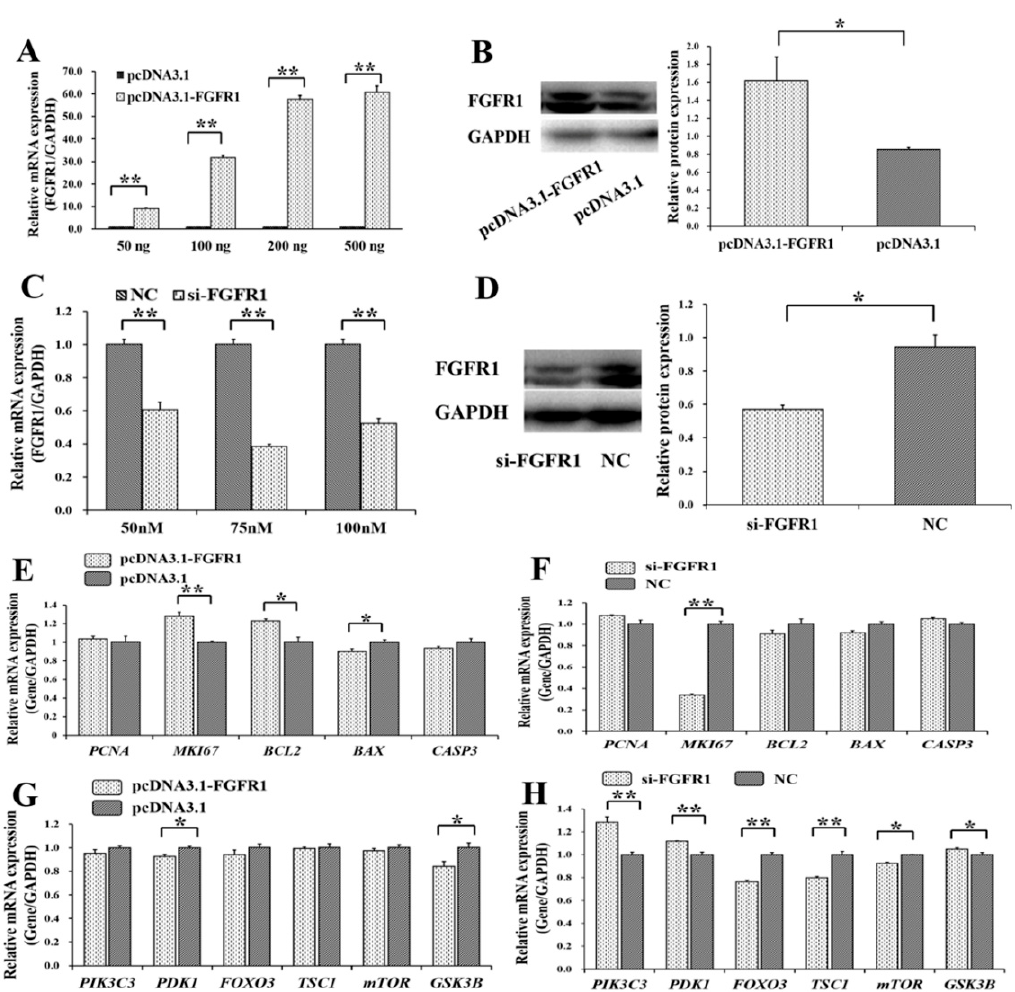
Figure 5. Biological effects of FGFR1 on apoptosis and PI3K signaling pathway. ( A ) The mRNA level of FGFR1 under different concentrations of pcDNA3.1-FGFR1 plasmid; ( B ) the FGFR1 protein count was stimulated by 200 ng of pcDNA3.1-FGFR1 plasmid; ( C ) the mRNA level of FGFR1 with different concentrations of siRNAs; ( D ) the FGFR1 protein count was suppressed by 70 nM of si-FGFR1. The relative mRNA expressions of genes from apoptosis signaling pathway after treatment by pcDNA3.1-FGFR1 ( E ) and si-FGFR1 ( F ); The relative mRNA expressions of genes from PI3K signaling pathway after treatment by pcDNA3.1-FGFR1 ( G ) and si-FGFR1 ( H ). * indicates p < 0.05; ** indicates p < 0.01. Data are represented as means ± SD. NC: negative control. Si-FGFR1: specific siRNA for FGFR1 . PcDNA3.1-FGFR1: pcDNA3.1 overexpression plasmid of FGFR1 .